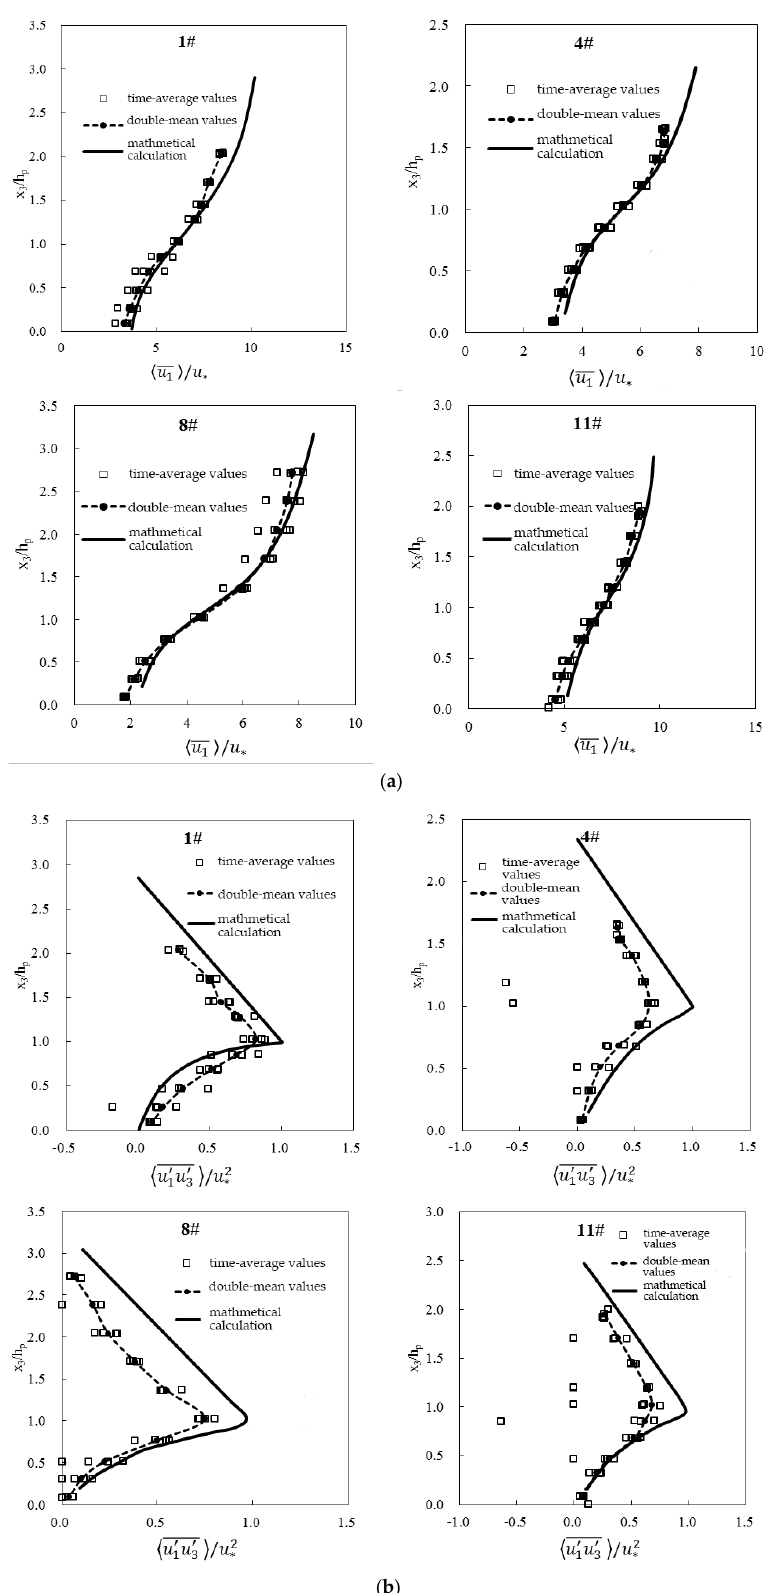
Figure 3. Verification calculation results of the double-mean longitudinal velocity and Reynolds stress (experimental data source: Dunn et al. [1]): ( a ) verification calculation results of the double mean longitudinal velocity; ( b ) verification calculation results of the double-mean Reynolds stress.